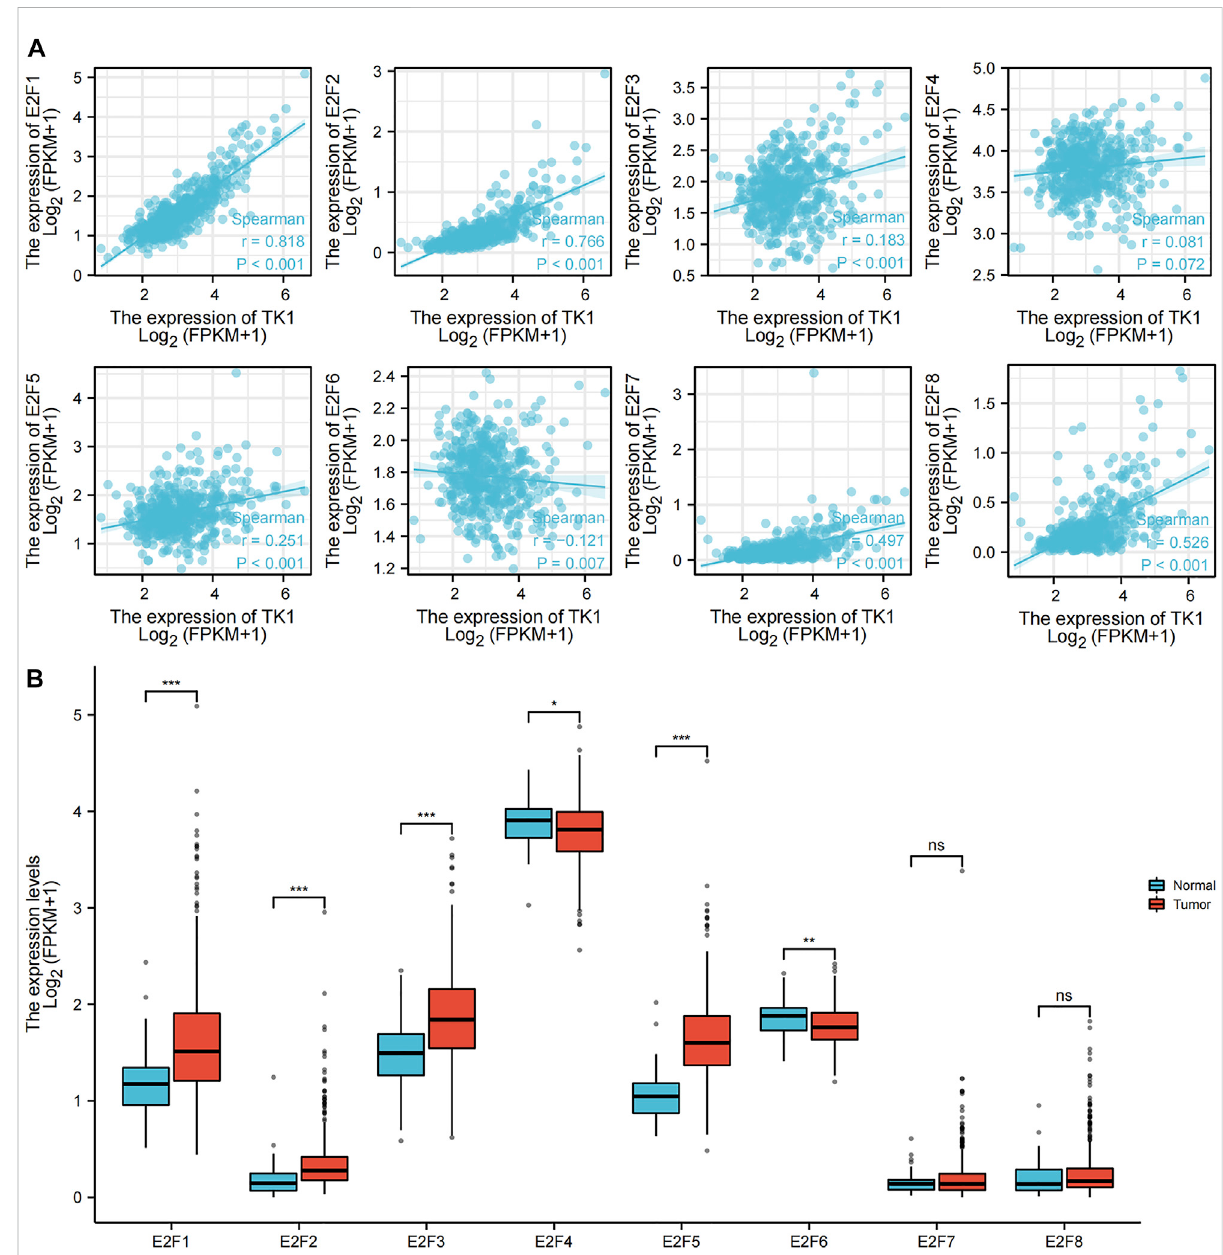
FIGURE 6 Association of TK1 and E2Fs in PCa. (A) Molecular correlation analysis of TK1 and E2Fs. (B) Human expression levels of E2Fs in PCa from The Cancer Genome Atlas (TCGA) data resource were estimated by the ggplot2 R package (v3.3.3) algorithm. (* < 0.05, ** < 0.01, *** <